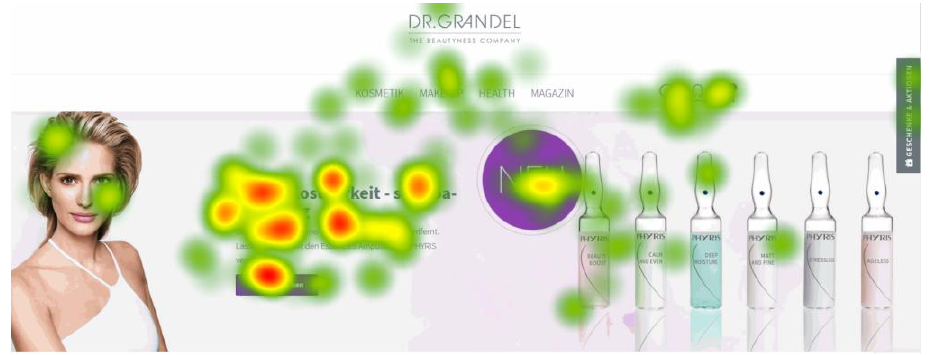
Figure 9. Heatmap for first time users of the website [34]. Fixation focuses on content